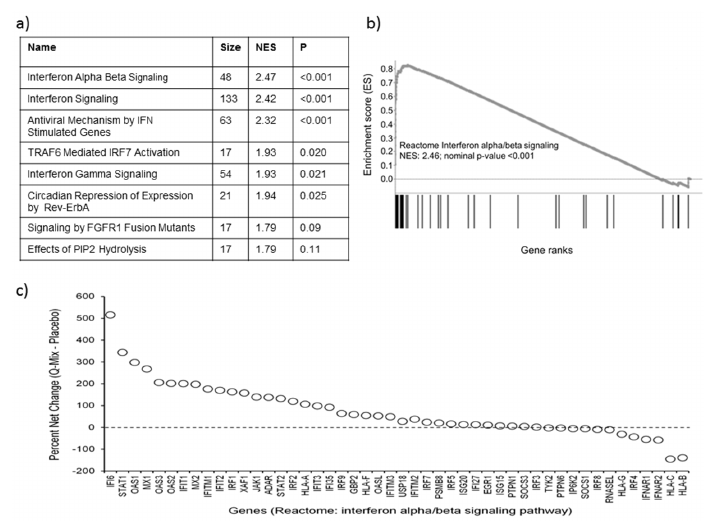
Figure 3. Differential regulation of interferon-signaling gene expression in Q-mix vs. placebo (Pbo). ( a ) Top-scoring Reactome pathways identified as upregulated in Q-mix relative to placebo by gene-set (pathway) enrichment analysis: Column 1, pathway names; column 2, number of genes in pathway; column 3, NES, a measure of pathway enrichment normalized for the number of genes in the pathway; column 4, false discovery rate (FDR) p -value. Pathways with FDR 2 ď 10% are shown; ( b ) Enrichment plot for the top-ranked Reactome pathway (interferon alpha/beta signalling), upregulated in Q-Mix compared to placebo. The graph represents the incremental change in the enrichment scores for this pathway during gene-set enrichment analysis (maximized at 0.82). Relative positions of genes belonging to this pathway are indicated by the bars under the graph. Lines clustered to the left represent higher ranked genes in the pre-ranked gene list; ( c ) Differential expression profiles for genes belonging to the interferon alpha beta signaling pathway, rank-ordered by their percent net expression change between Q-Mix and placebo.